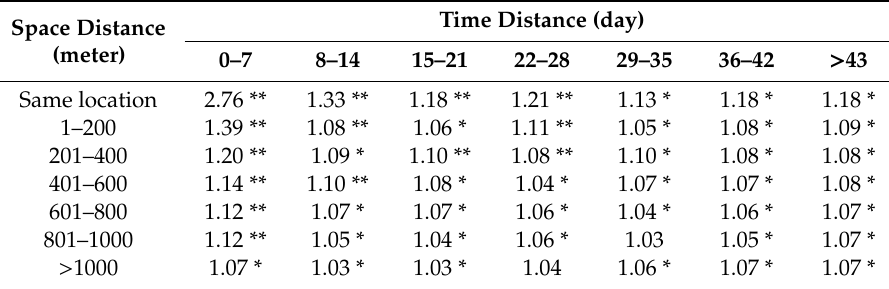
Table 1. Repeat and near-repeat matrix of